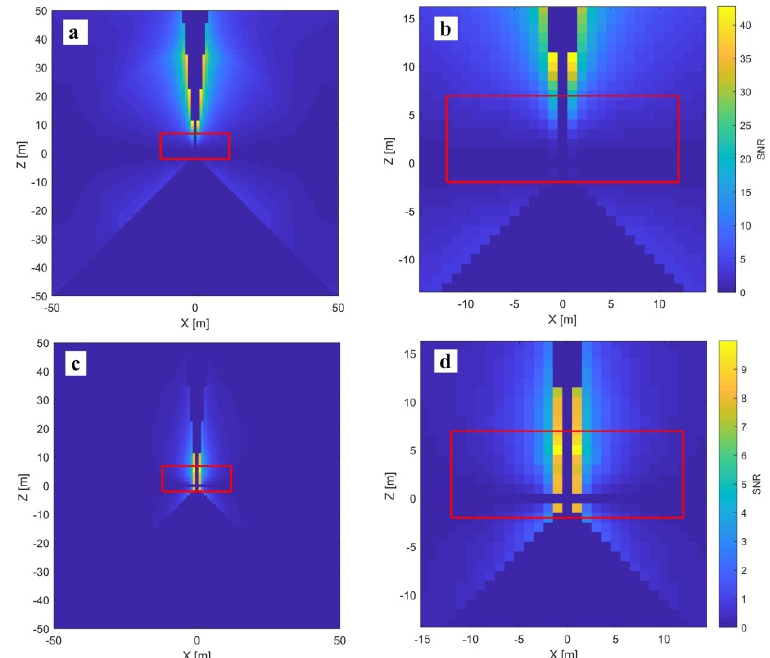
Figure 12. SNR for x 1 z and x 5 z + 7 in a vertical plane—full field of view ( a , c ) and the close-up ( b , d Figure 12. SNR for 𝑥 (cid:2869)(cid:3053) and 𝑥 (cid:2873)(cid:3053)(cid:2878)(cid:2875) in a vertical plane—full field of view ( a , c ) and the close-up ( b , d )